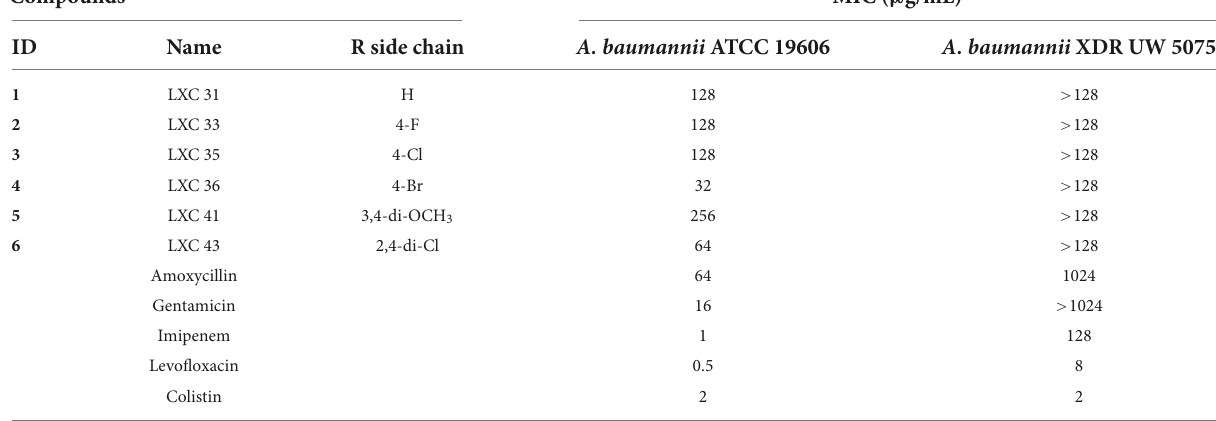
TABLE 1 Minimum Inhibitory Concentration (MIC) of the LXC compounds and common antimicrobial agents on two strains of Acinetobacter baumannii . Compounds